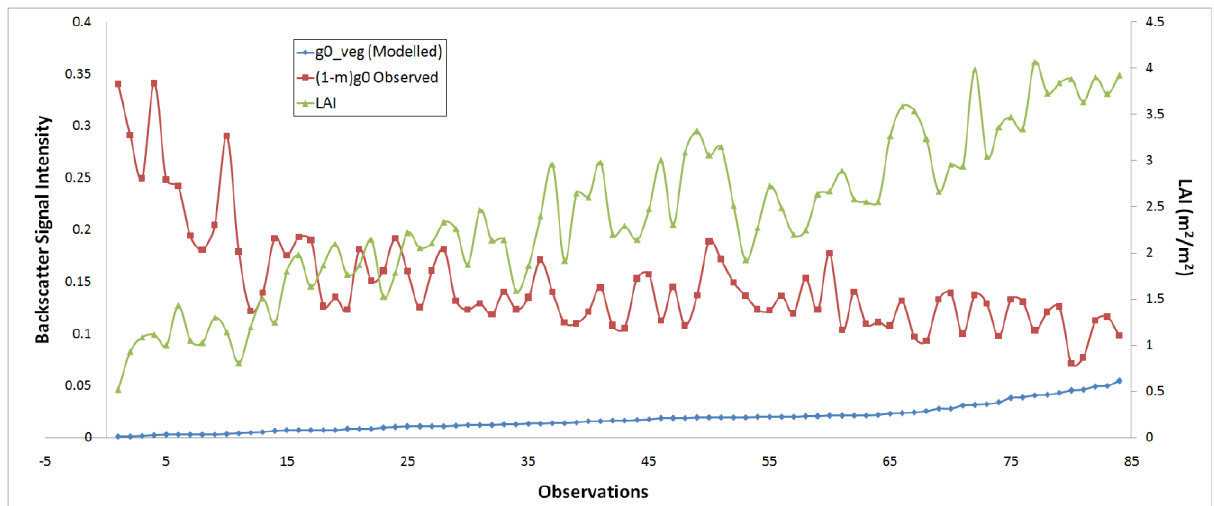
Figure 4. Plot of g 0 _veg (modeled) and (1-m)g 0 observed in corresponding with in-situ